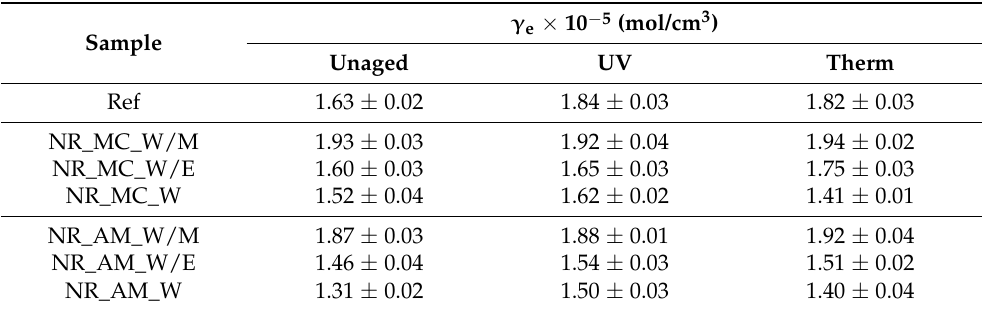
Table 5. Results of the cross-linking density ( γ e ) before degradation process (Unaged) and after ultraviolet (UV) and thermo-oxidative (Therm)